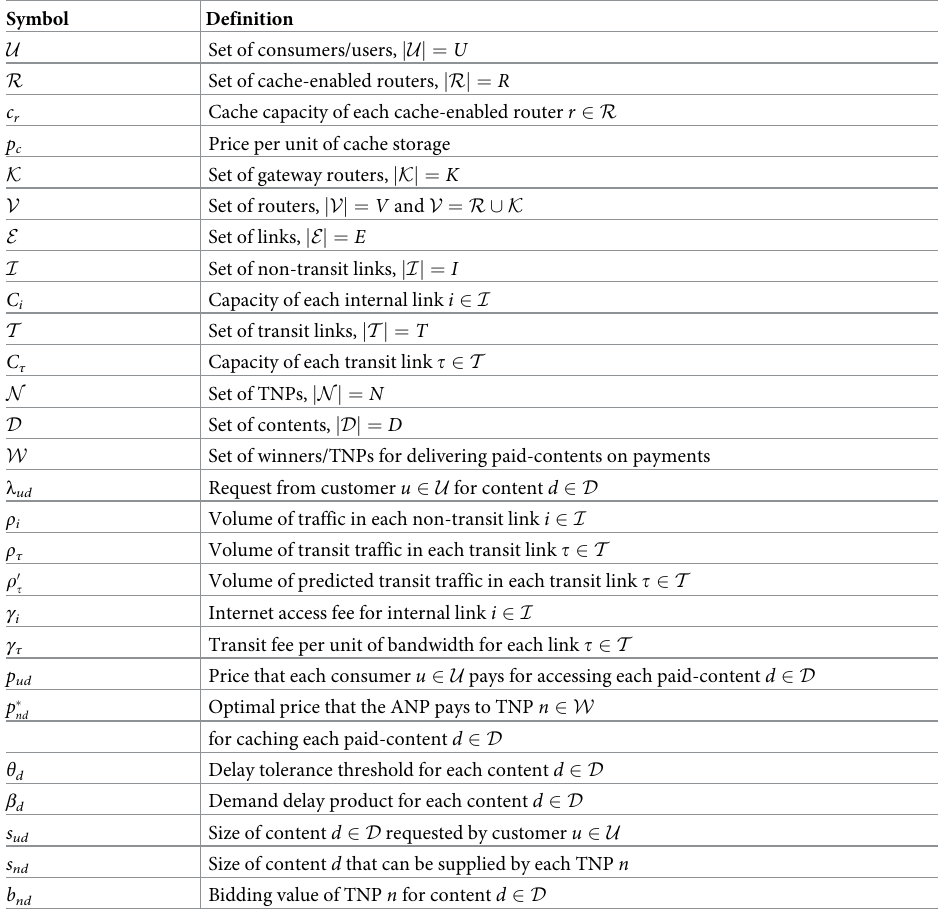
Table 1. Summary of key notations.